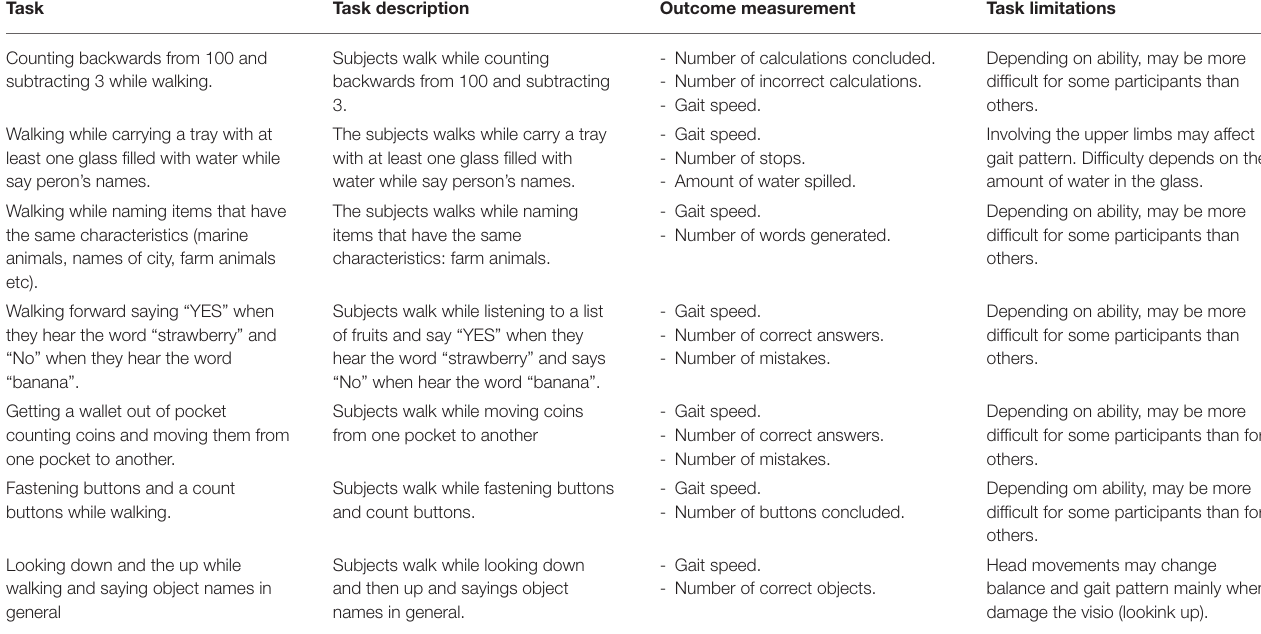
TABLE 3 | Dual-task training at difficulty level